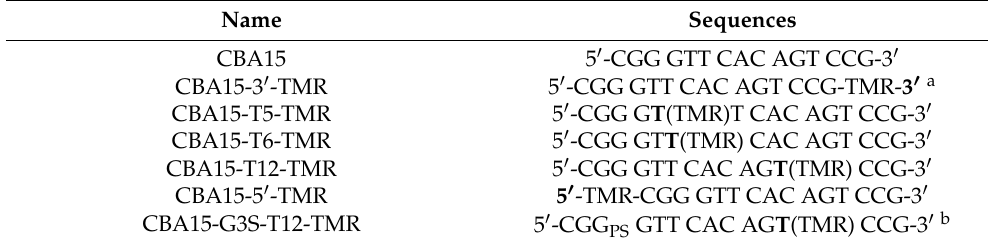
Table 1. List of the DNA oligonucleotides.